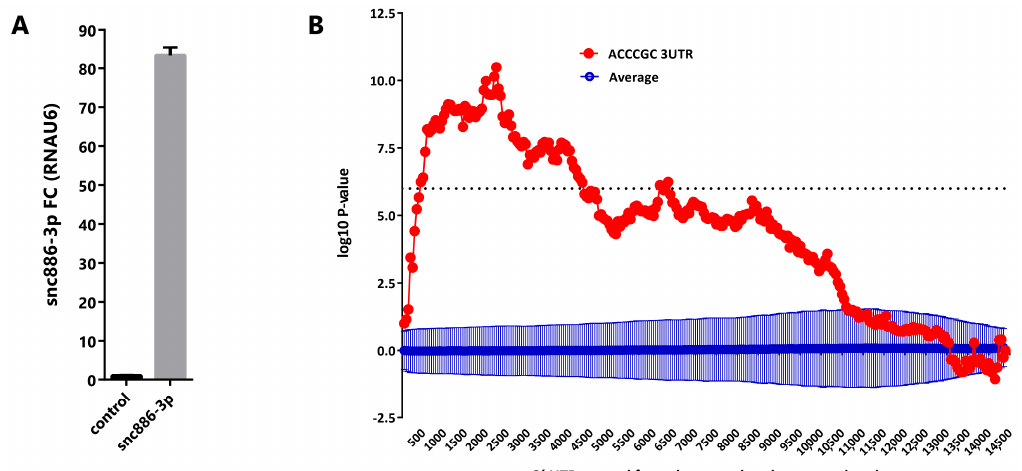
Figure 3. Snc886-3p downregulates transcripts bearing a 5 ′ ACCCGC3 ′ sequence complementary to its putative seed in their 3 ′ -UTR. ( A ) Expression of snc886-3p in DU145 cells transfected with 20nM of mimic snc886-3p and negative control (Dharmacon) after 48 h. Quantification by qRT-PCR using RNAU6 as a normalizer. ( B ) Sylamer enrichment landscape plot for 6-nt k-mer in all genes ranked by their change in abundance after snc886-3p overexpression compared to control determined by Affymetrix microarrays. The x -axis represents the sorted gene list (downregulated and upregulated genes are plotted in the left and right part of the axis respectively). The y -axis shows the hypergeometric significance for each 6-nt k-mer at each leading bin. Positive and negative values indicate enrichment or depletion of the 6-nt k-mer sequence at the 3 ′ -UTR of the genes. The dotted horizontal line symbolizes an E-value threshold of 0.01 (Bonferroni corrected). The red line embodies the values obtained for the 6-nt k-mer (5 ′ ACCCGC3 ′ ) complementary to the 6-nt seed (6-mer, 2-7-nt) of snc886-3p. The blue line shows the average profile of 6-nt k-mer unrelated to the seed region of snc886-3p (dark blue), with standard deviation as vertical bars.